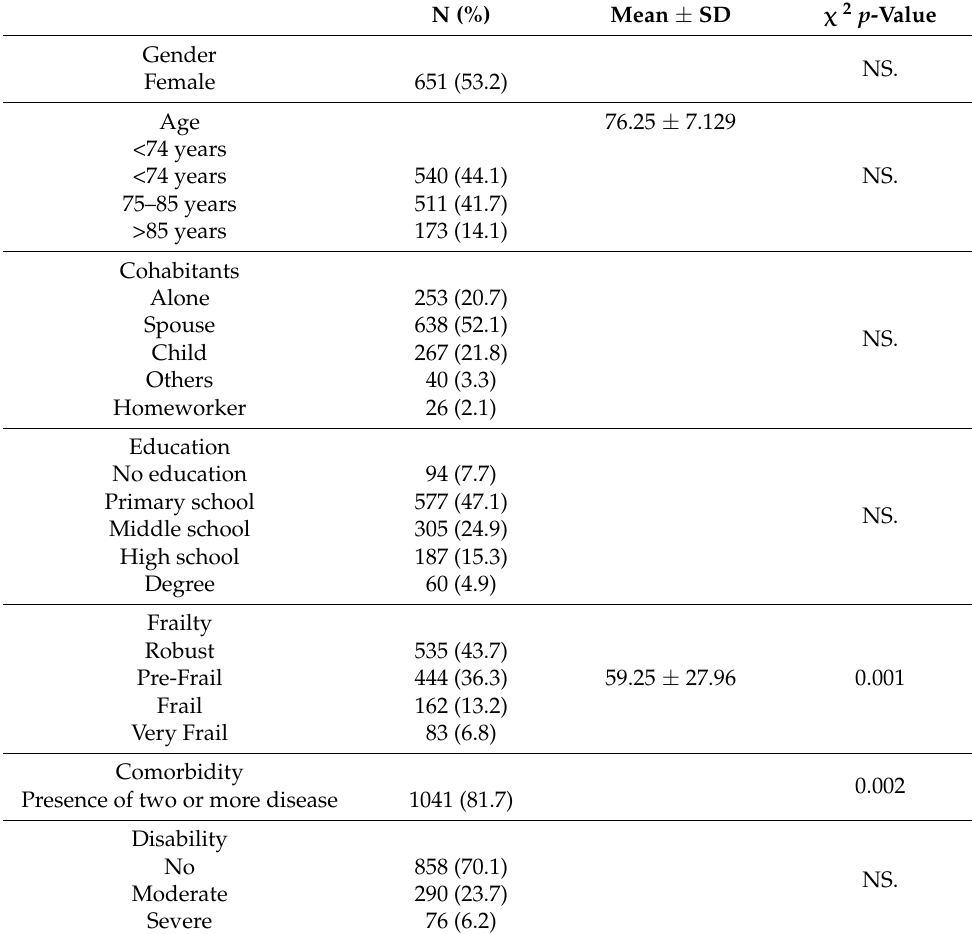
Table 1. Main characteristic of the sample (N =